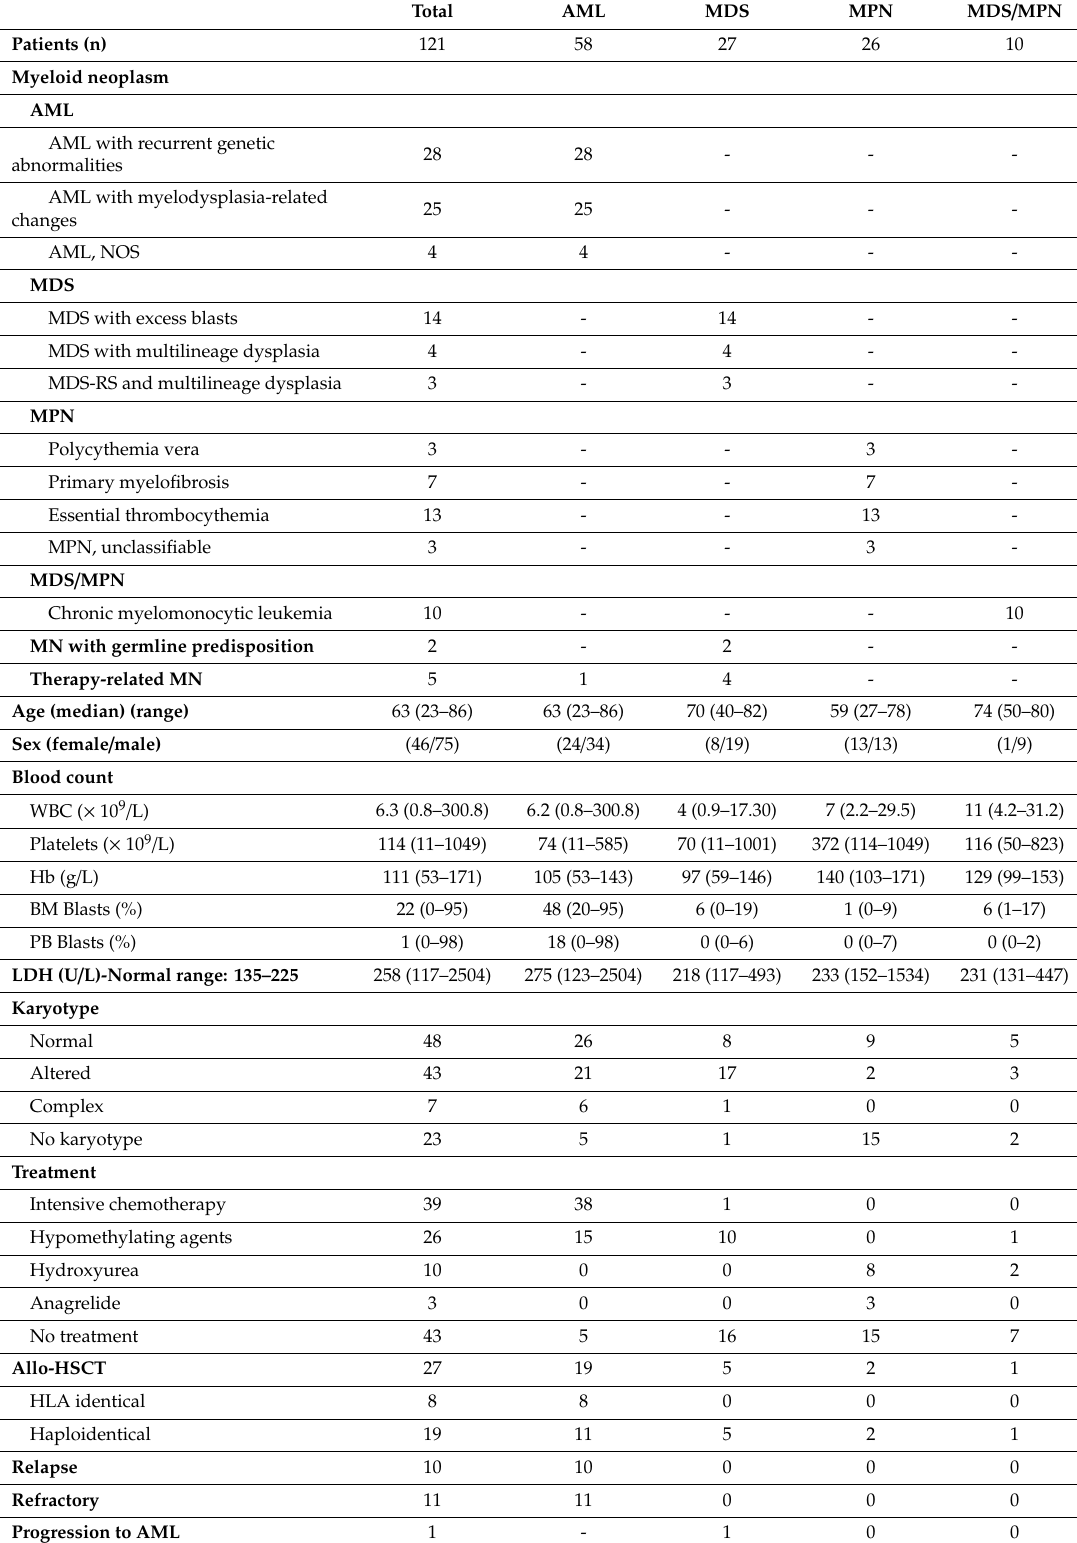
Table 1. Clinical characteristics of the 121 patients with myeloid neoplasms. AML: acute myeloid leukemia. MPN: myeloproliferative neoplasm. MDS: myelodysplastic syndrome. MN: myeloid neoplasm. WBC: white cell count. Hb: hemoglobin. HSCT: hematopoietic stem cell